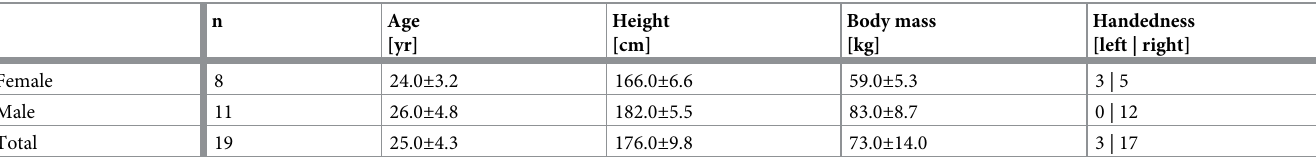
Table 12. Demographic data of the participants (mean ±